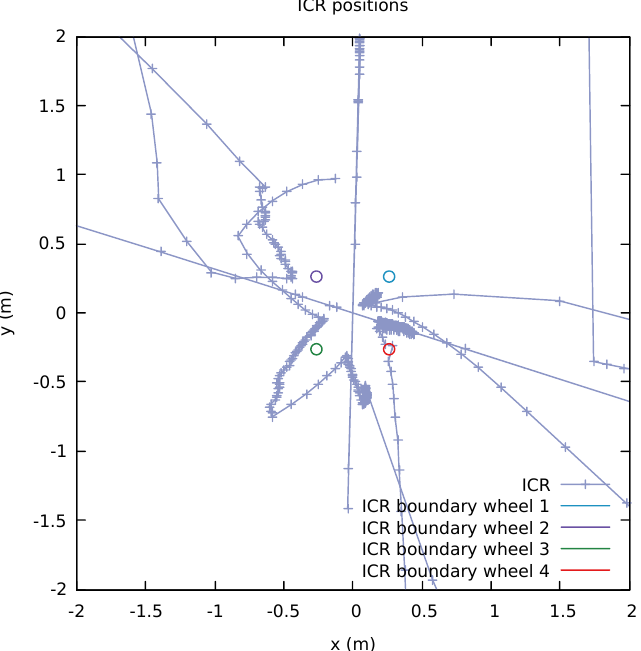
Figure 6. An example of the locations of ICR when moving around the platform, where the line represents the the consecutive changes of ICR locations. One can see the effect of ω (Equation (7)) that a relatively large change in ICR happens when there is low rotational velocity ω . In this example, we can see that the ICR was close to the boundary of wheel 4 (red) and probably was adjusted to stay outside the boundary. Note that to smoothly move from pure rotational velocity to linear velocity the ICR point has to incrementally move from the center passing in between the ICR constraint regions, therefore it is important to make the ICR constraint region not larger than